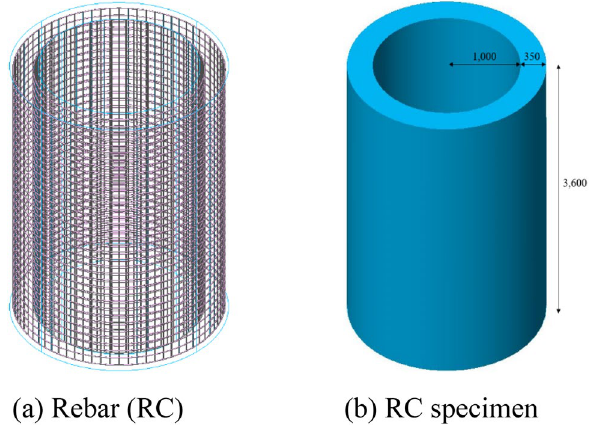
Figure 2. Rebar and specimen details (unit : mm). ( a ) Rebar (RC). ( b ) RC specimen.